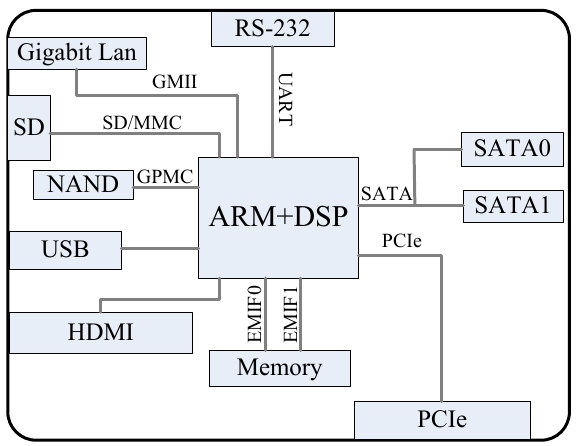
Figure 2. Diagram of data processing module